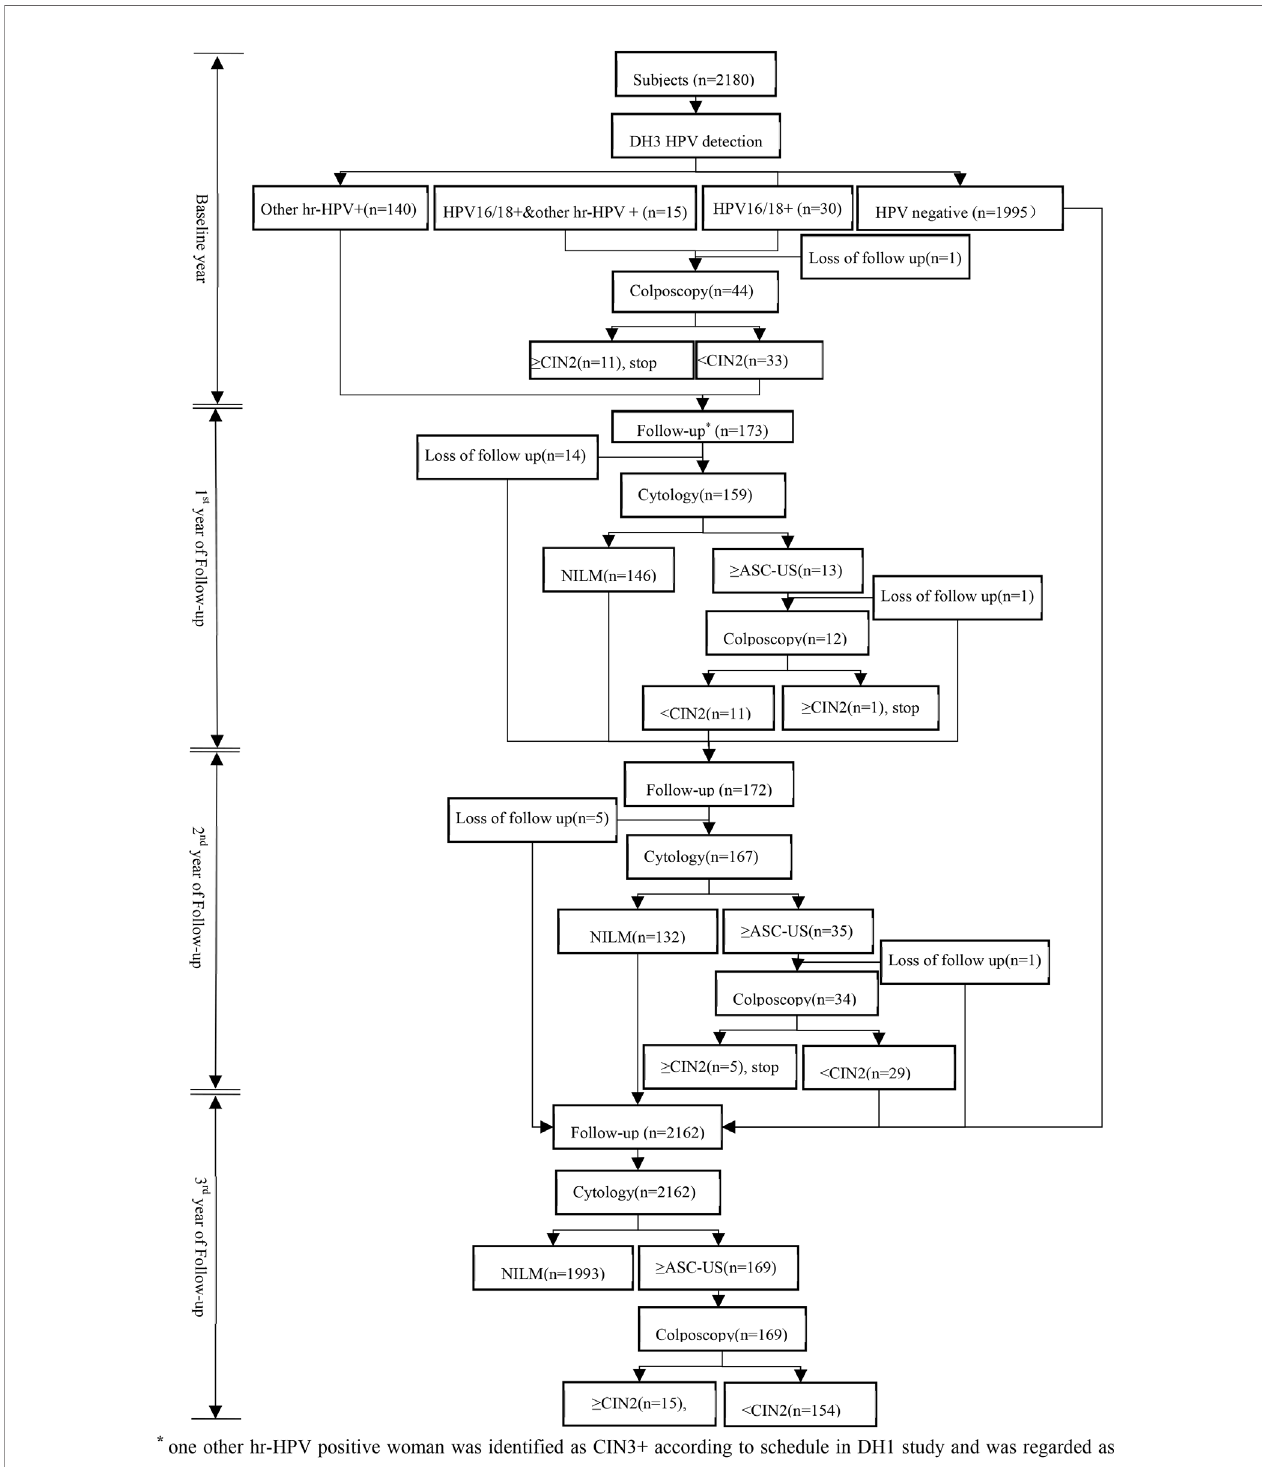
FIGURE 1 | Study fl